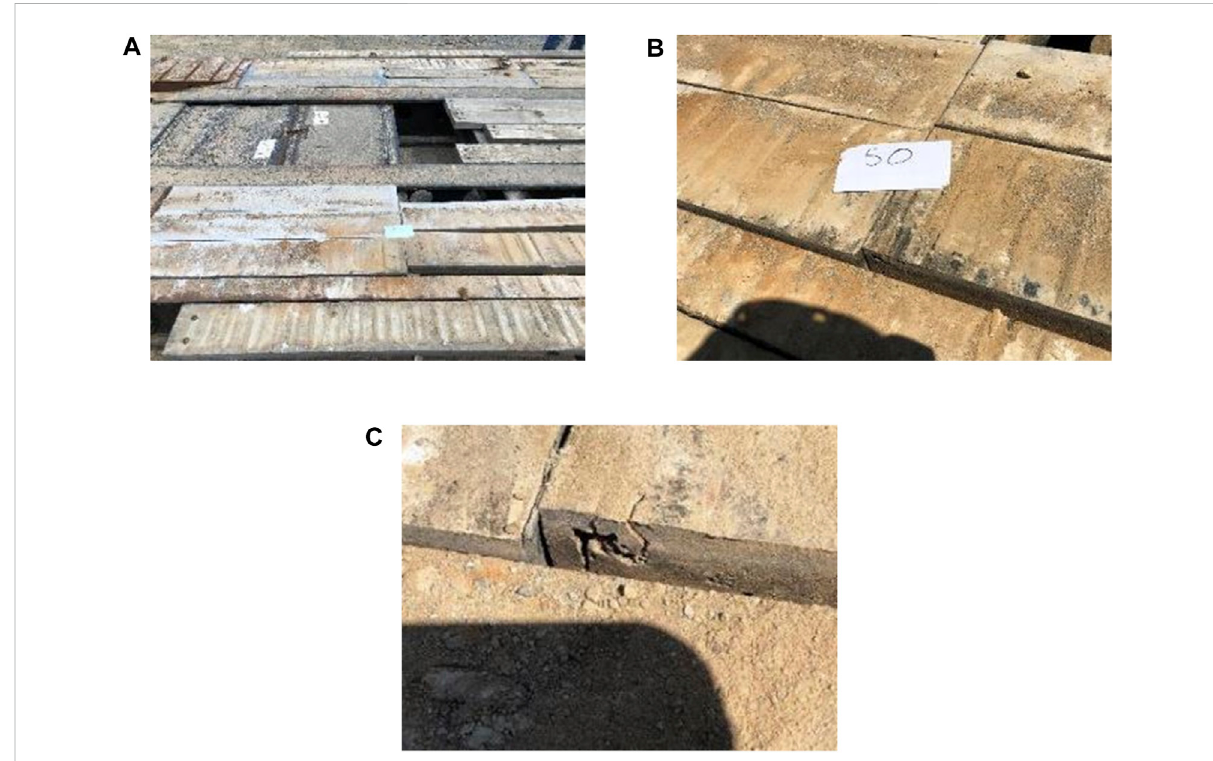
FIGURE 13 Tread wear; (A) Illustration of placement of the PP-BF-BS planks as explain before; (B) Tread marks due to several loading/unloading trials of driving the CAT over the planks back and forth; and (C) Localized cracking in the area of BS that had less binding to the jacket.